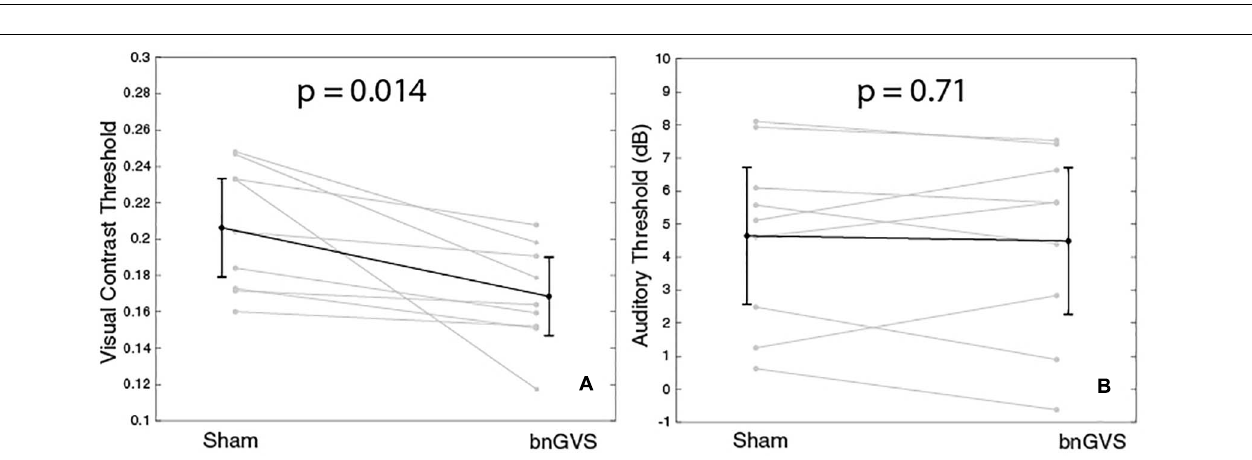
FIGURE 5 | Plots to show visual and auditory thresholds with and without GVS. Panel (A) shows a statistically significant improvement in visual contrast thresholds with bnGVS. (B) shows small or no change in auditory thresholds.